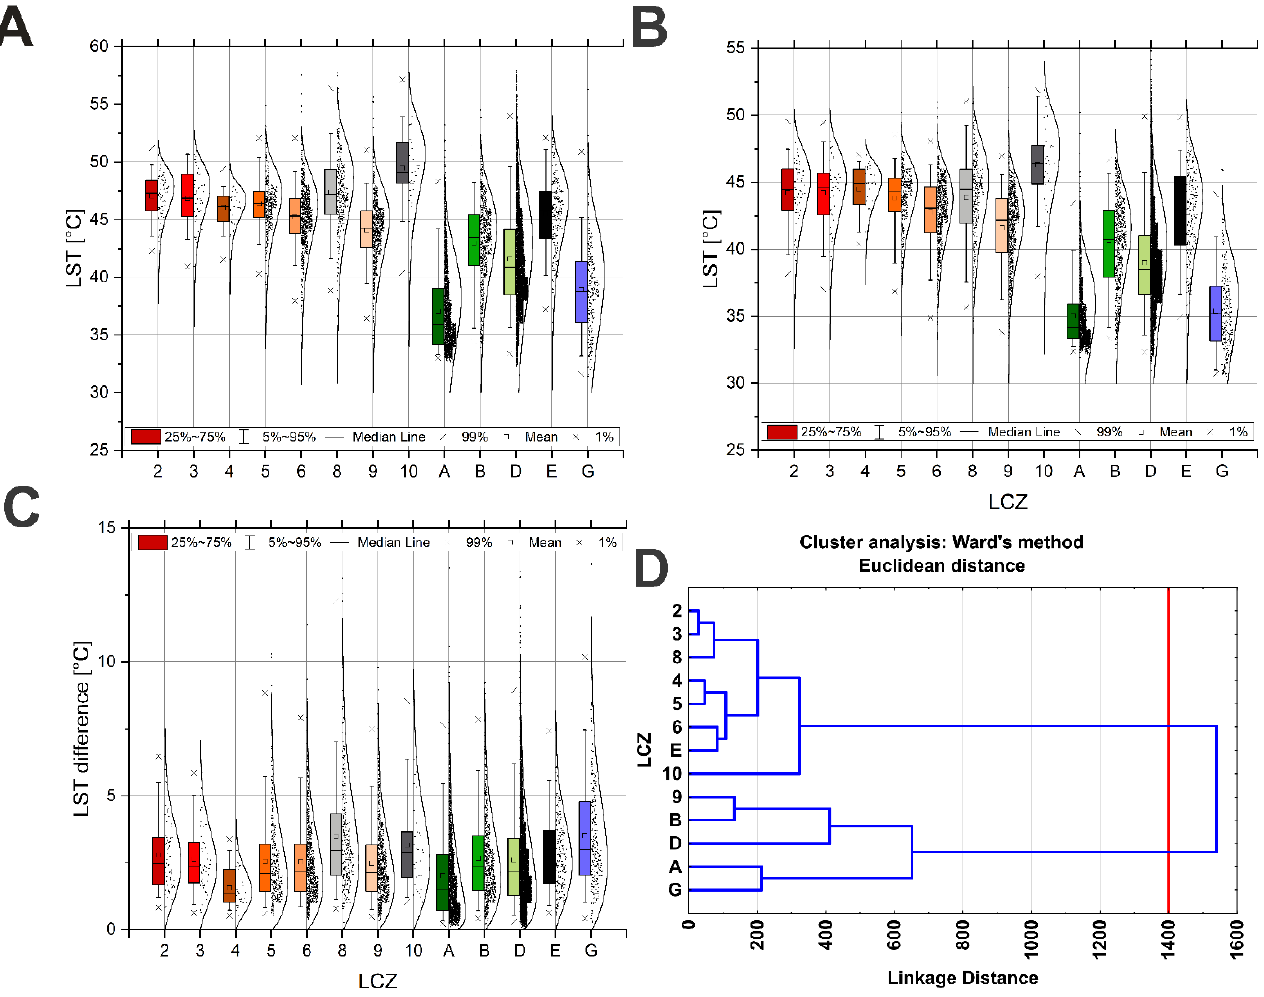
Figure 7. Box-plots with LSTs in LCZ classes in 27 July 2013; see Figure 3 for the LCZ key. Left up ( A ) mean maximum of LST; right up ( B ) mean minimum of LST; left down ( C ) mean difference (mean max LST minus mean min LST), values that are below/above the cross in the graph can be considered outliers when the cross symbolizes 1% of the values; right down ( D ) results of cluster analysis—the vertical red line represents the linkage chosen to select the clusters (red line in the cluster analysis refers to α = 0.05 significance level).